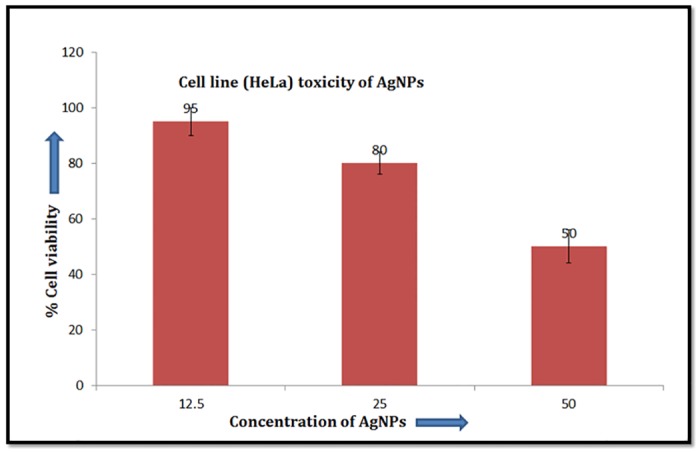
Cell line (HeLa) toxicity assessment of the AgNPs.Error bars represent standard deviations of triplicate incubations.